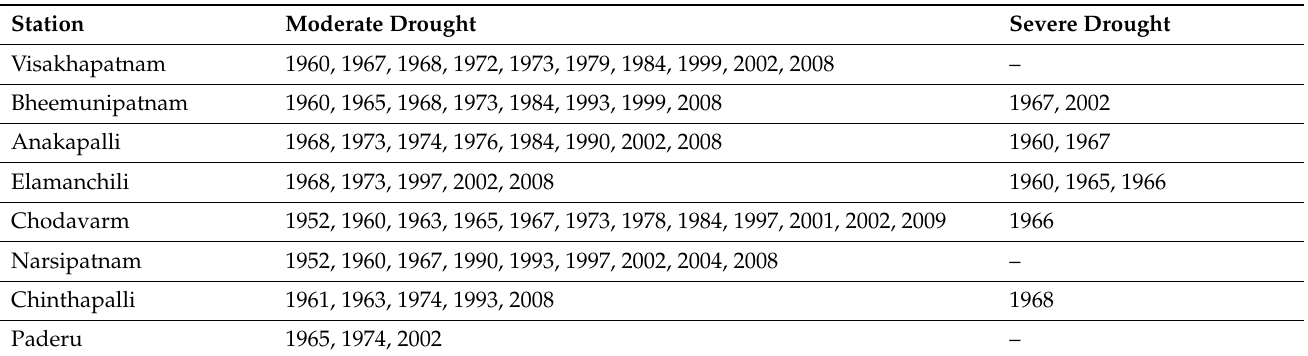
Table 3. Visakhapatnam district: droughts